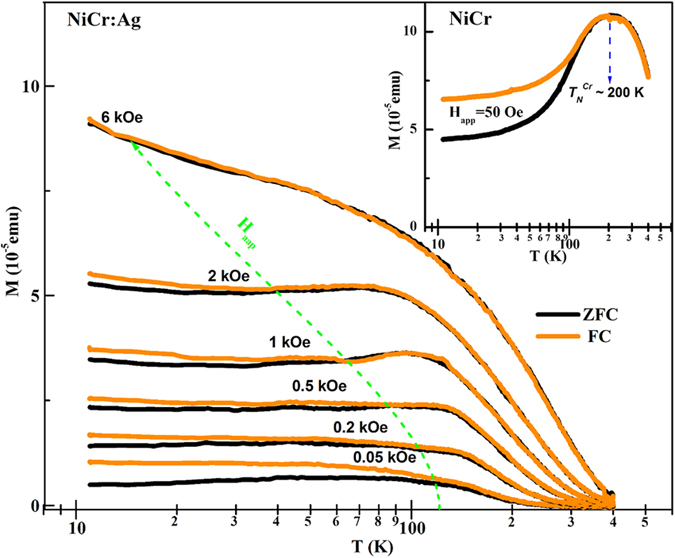
ZFC and FC magnetization curves of Ni95Cr5:Ag nanocomposite as a function of temperature (log scale).Measuring applied field Happ: 0.05 kOe; 0.2 kOe; 0.5 kOe; 1 kOe; 2 kOe; 6 kOe. Inset shows ZFC and FC magnetization curves measured at Happ = 0.05 kOe for bare Ni95Cr5 nanoalloy film.